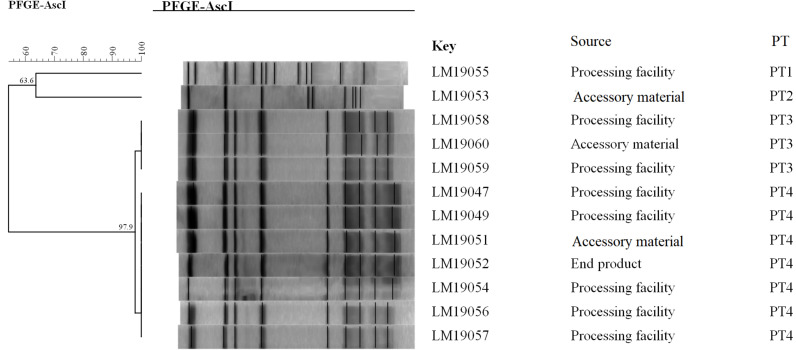
Relationships of the L. monocytogenes isolates based on PFGE. The 12 L. monocytogenes isolates were analyzed by PFGE using AscI.